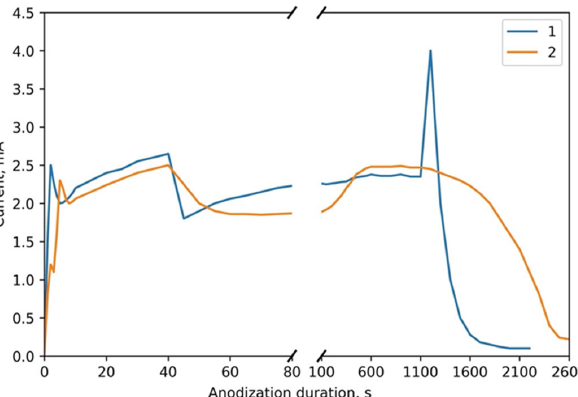
Figure 4. CVA curves of the simultaneous anodic treatment of the two ‐ layer thin ‐ film composition of Al (100 nm) on Ta (400 nm) for type II samples: 1 —sample No. 3; 2 —Al only (1000 nm).